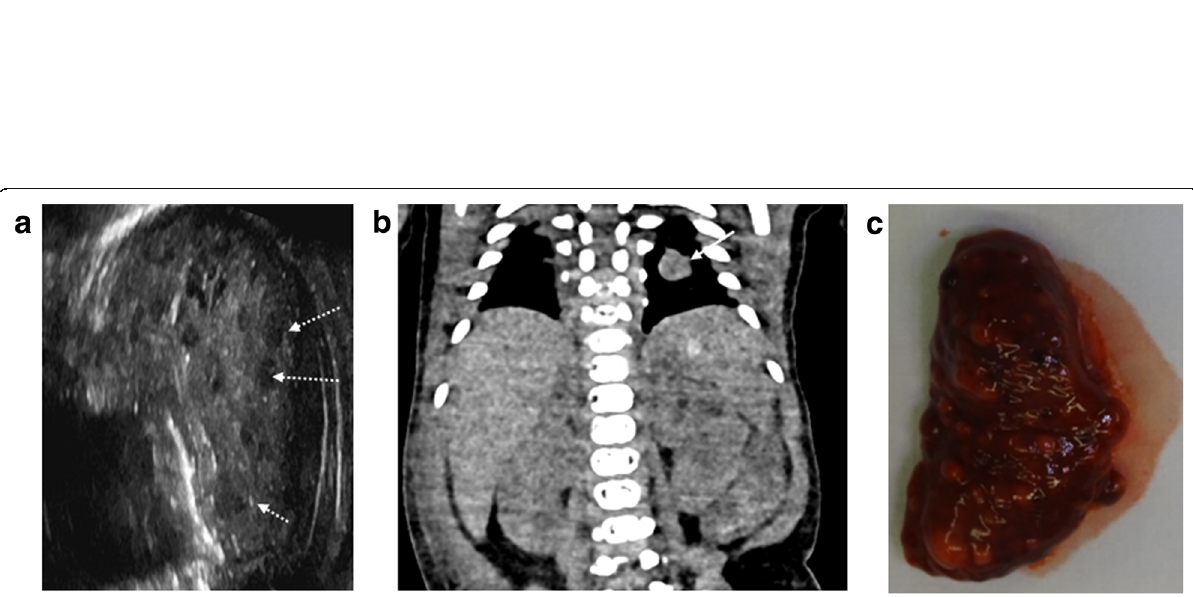
Fig. 14 a – c Multiple splenic metastases from infantile fibrosarcoma in a 14 day old neonate (same case as in Fig. 9). Post-mortem imaging was performed 3 days after death. The post-mortem ultrasound in coronal section ( a ) demonstrates numerous hypoechoic lesions throughout the spleen (dotted arrows). On the corresponding coronal unenhanced CT image of the upper abdomen ( b ), the splenic lesions are less apparent, although a pulmonary metastasis in the left lung (solid arrow) is noted. At autopsy, the extracted spleen ( c ) reveals numerous solid